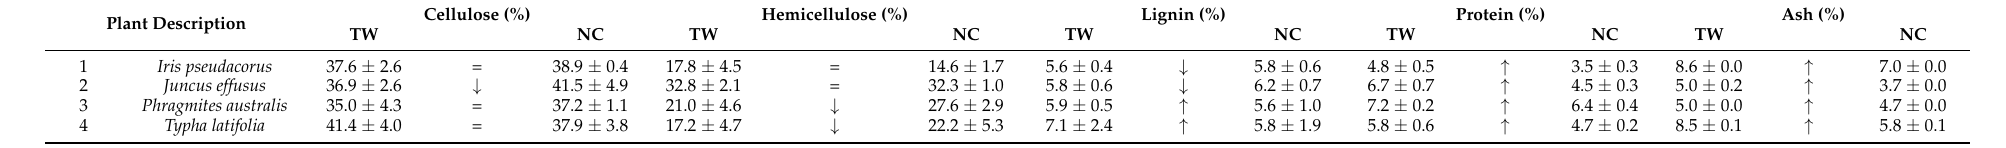
Table 1. Cellulose, hemicellulose, lignin, and protein content in the selected plants for the different growing environments.